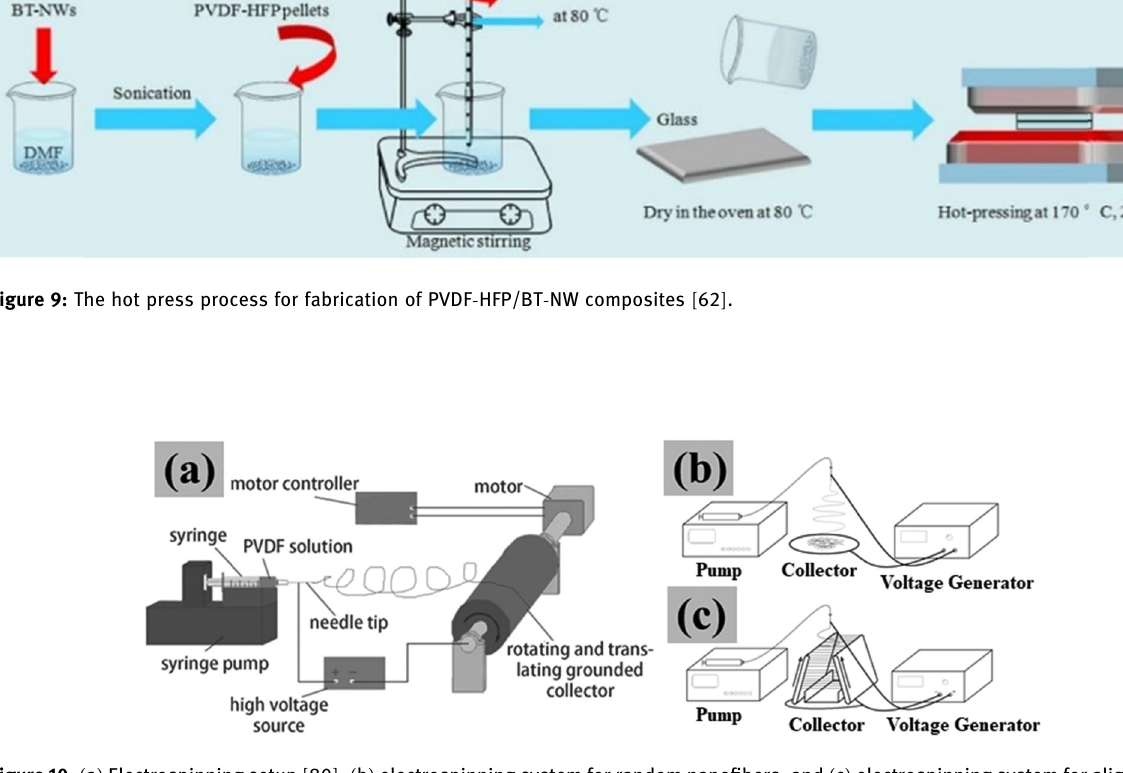
Figure 10: ( a ) Electrospinning setup [ 80 ] ; ( b ) electrospinning system for random nano fi bers; and ( c ) electrospinning system for aligned and stretched nano fi bers [ 5 ]